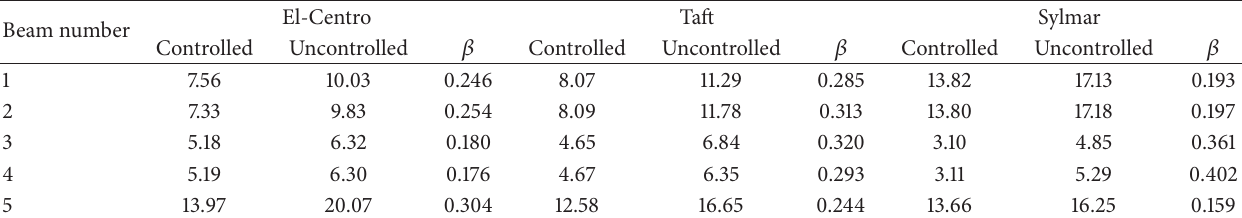
Table 6: Control effect of peak axial force under seismic excitations scaled to 0.4 g amplitude (units in kN). Beam